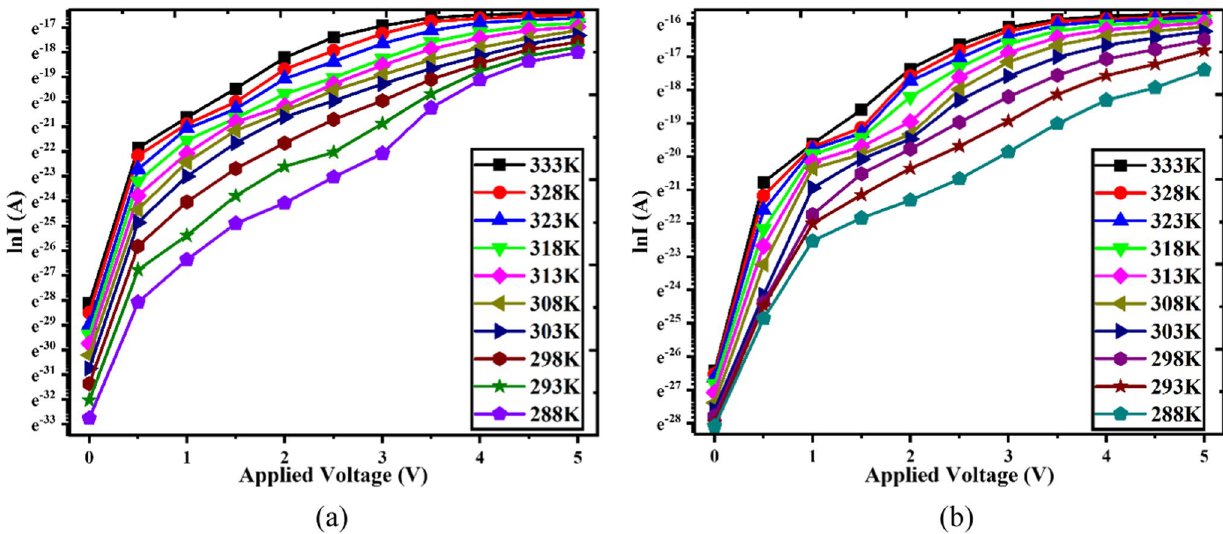
Fig.6 ln I–V plot of TZ dye; a without TiO